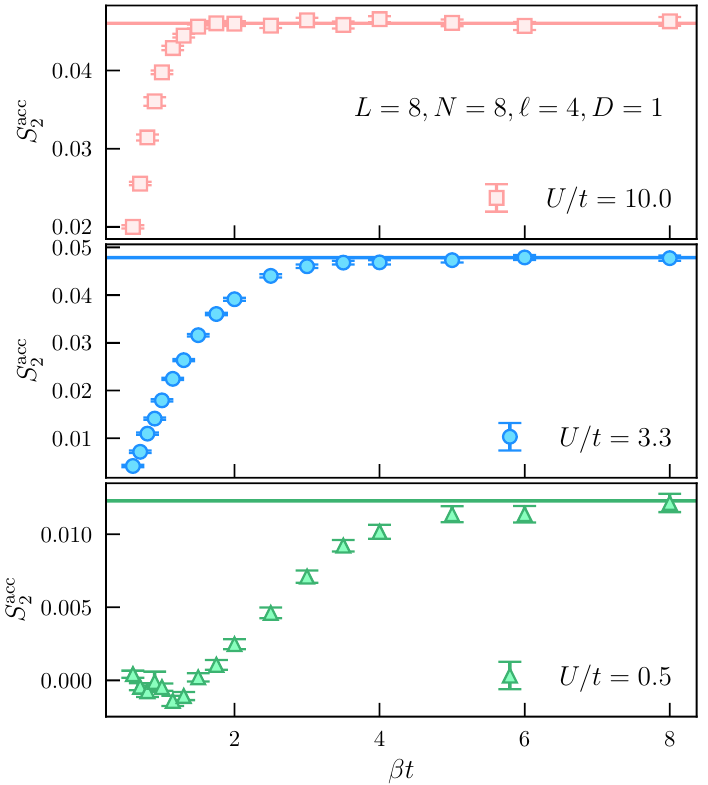
Figure 12: β -scaling of the accessible entanglement S acc